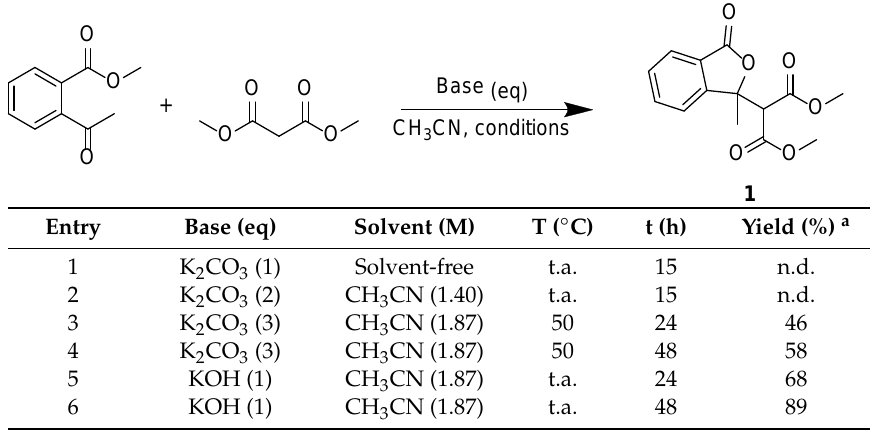
Table 1. Optimization of reaction conditions for cross-aldol / lactonization process.